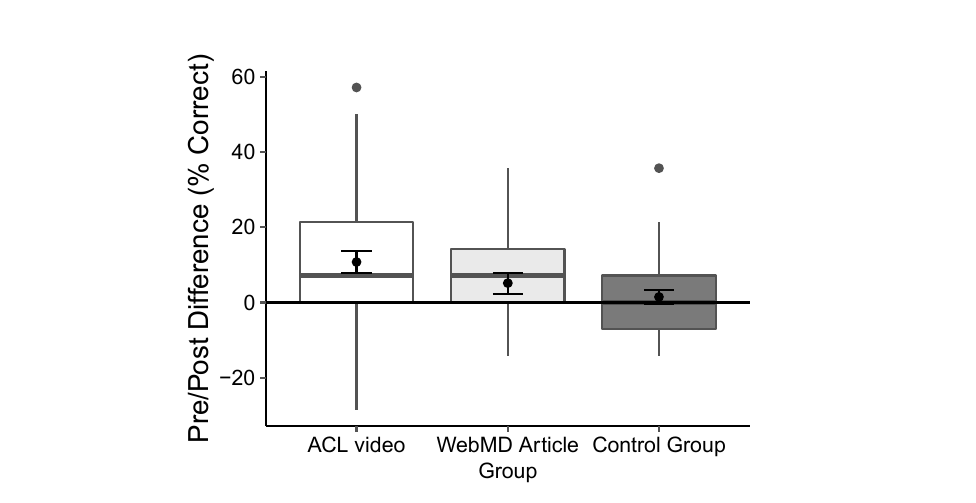
Figure 2. Change in percent correct on overall comprehension between time 1 and time 2 by condition. Black points inside the error bars within the boxplot represent the means and 95% confidence intervals while the black points outside the box represent outliers.